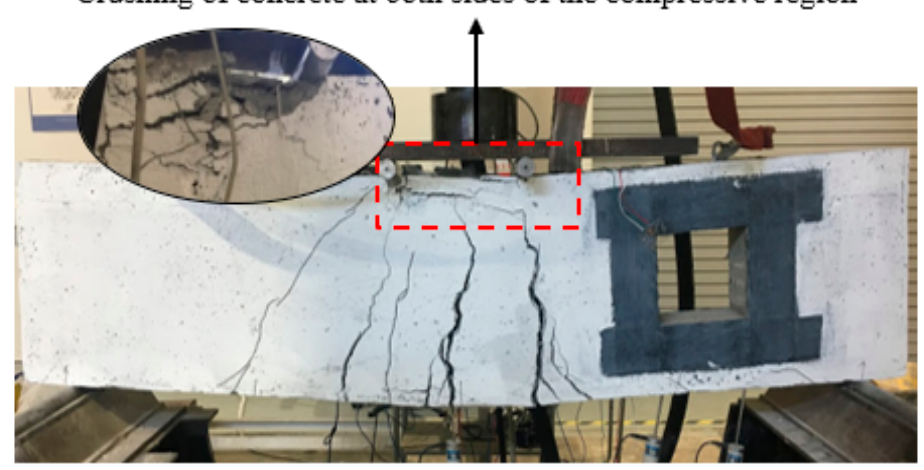
Figure 11. Failure mode and cracking pattern of deep beam B2c.